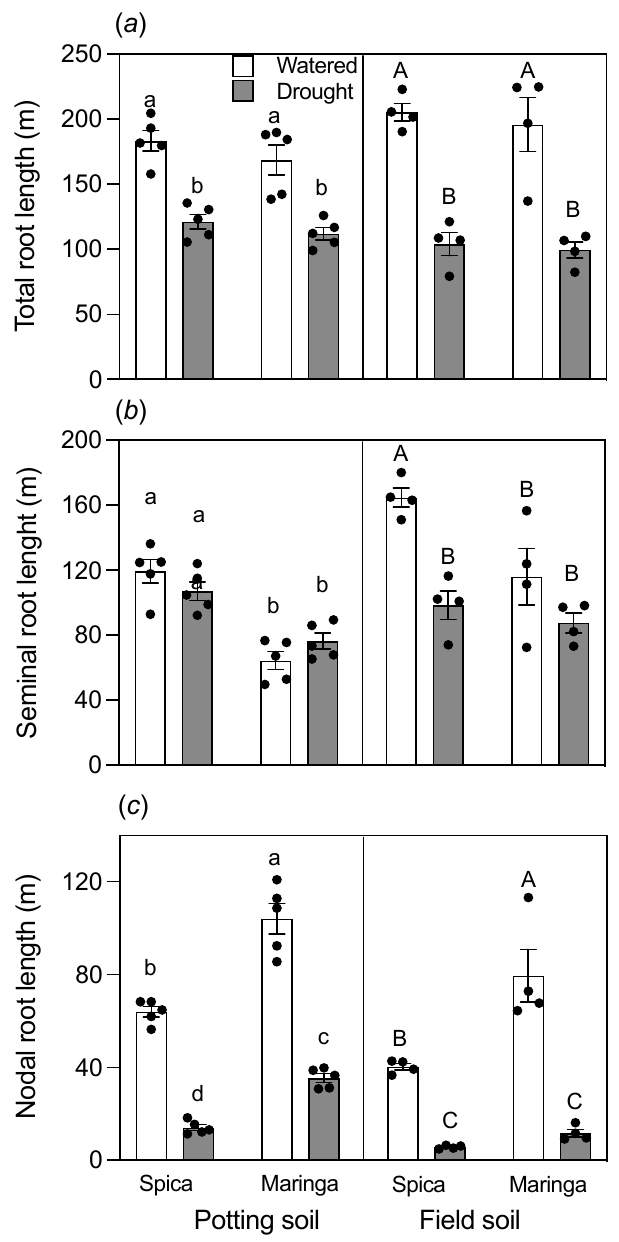
Figure 4. Total root lengths of Spica and Maringa were similar, but the relative proportions contributed by seminal and nodal roots differed. Total root length ( a ), seminal root length ( b ), and total nodal root length ( c ) of the two genotypes in watered (empty bars) and drought (filled bars) treatments after 28 d of growth. Individual values are shown as circles, and error bars represent ± SE of the mean for either five replicates (potting soil) or four replicates (field soil). Data for potting and field soils were analyzed separately by two-way ANOVAs. Different lowercase letters reflect signif- icant differences between treatments at p < 0.05 for potting soil, whereas different uppercase letters reflect significant differences between treatments as determined with the Tukey test at p < 0.05 for field soil. Analysis of nodal root length of Spica and Maringa under drought in the field soil by Student’s t -test in isolation of other data showed a significant difference ( p = 0.03), whereas the two- way ANOVA did not show significance at p < 0.05. The interaction between water and cultivar fac- tors for potting soil was ( a ) not significant for total root length, ( b ) not significant for seminal root length, and ( c ) significant at p < 0.05 for nodal root length. The interaction between water and culti- var factors for field soil was ( a ) not significant for total root length, ( b ) not significant for seminal root length, and ( c ) significant at p < 0.05 for nodal root length. whereas the nodal roots of Spica, although thinner under well-watered conditions, did not differ from Maringa under drought (Supplementary Figure S6). Drought stress signif- icantly increased root diameters of both Spica and Maringa across the two soil types. Maringa across both soils in the watered treatment that was not apparent on droughting (Supplementary Figure S7).